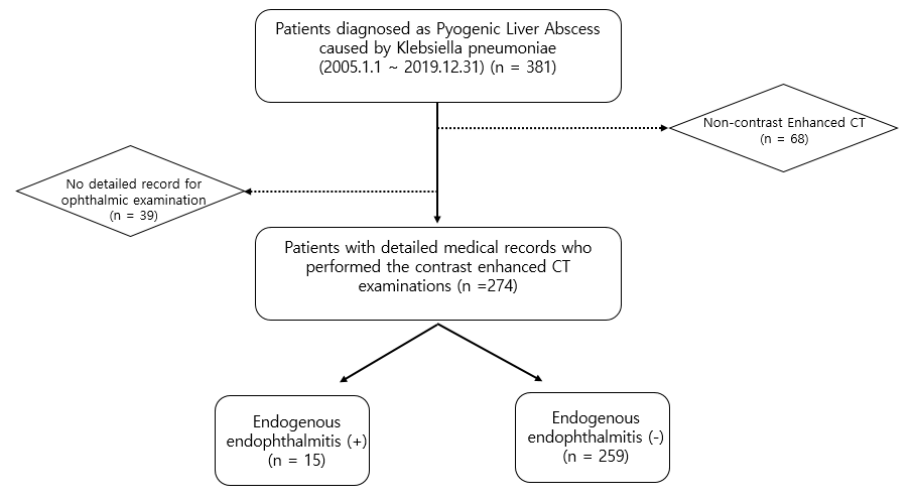
Figure 1. Flow diagram of the inclusion and exclusion criteria.